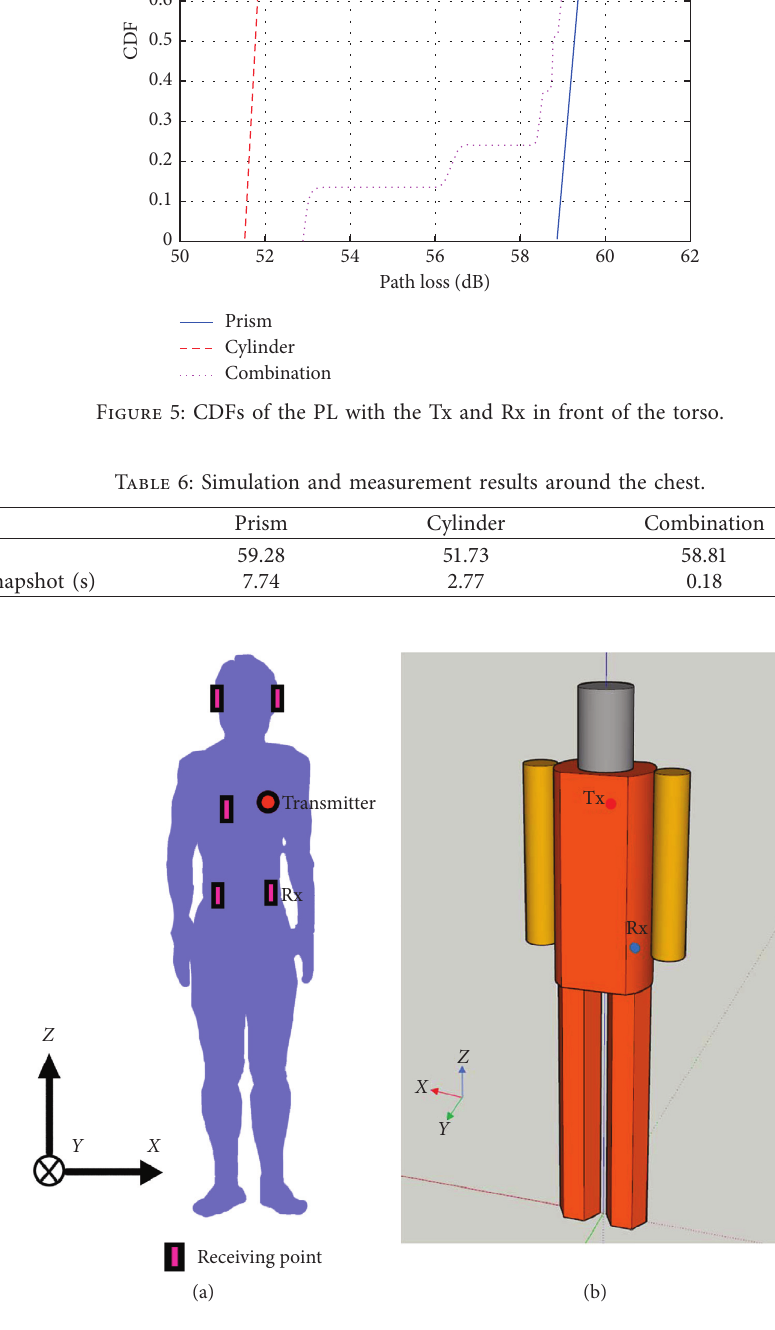
Figure 6: Positions of the Tx and Rx. (a) Measurement [23]. (b) Simulation with human body model 3 in Table